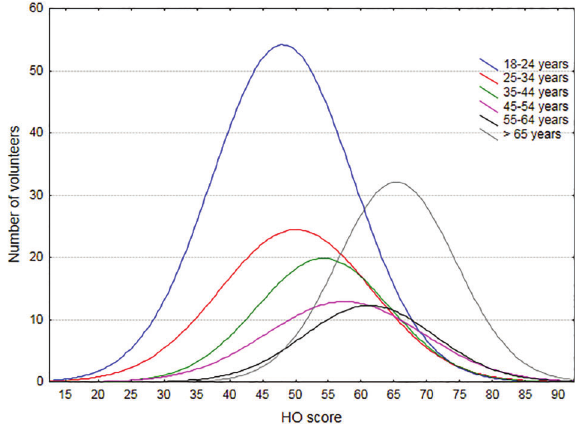
Figure 2. Averaged Pittsburgh Sleep Quality Index per age group. Data are reported as means ± SE for each age range. Covariate means (HO score): 53.89. *P o 0.05 compared to the other groups, except the 55 – 64 group; # P o 0.05 compared to the 18 – 24 group (Fisher LSD